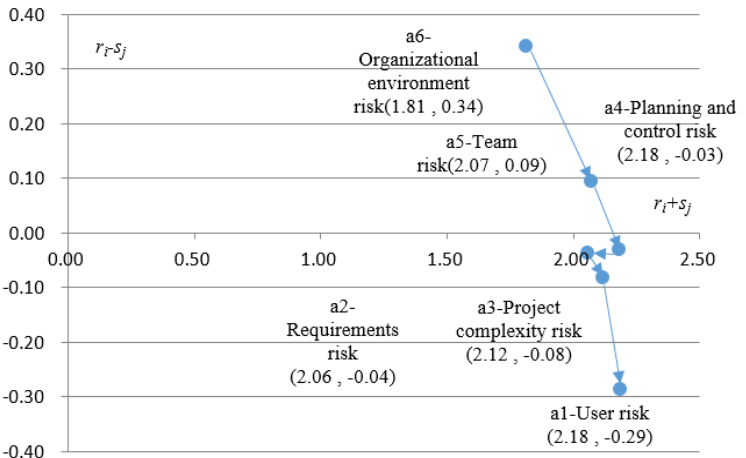
Figure 4. Dimension A–criterion of IRM.